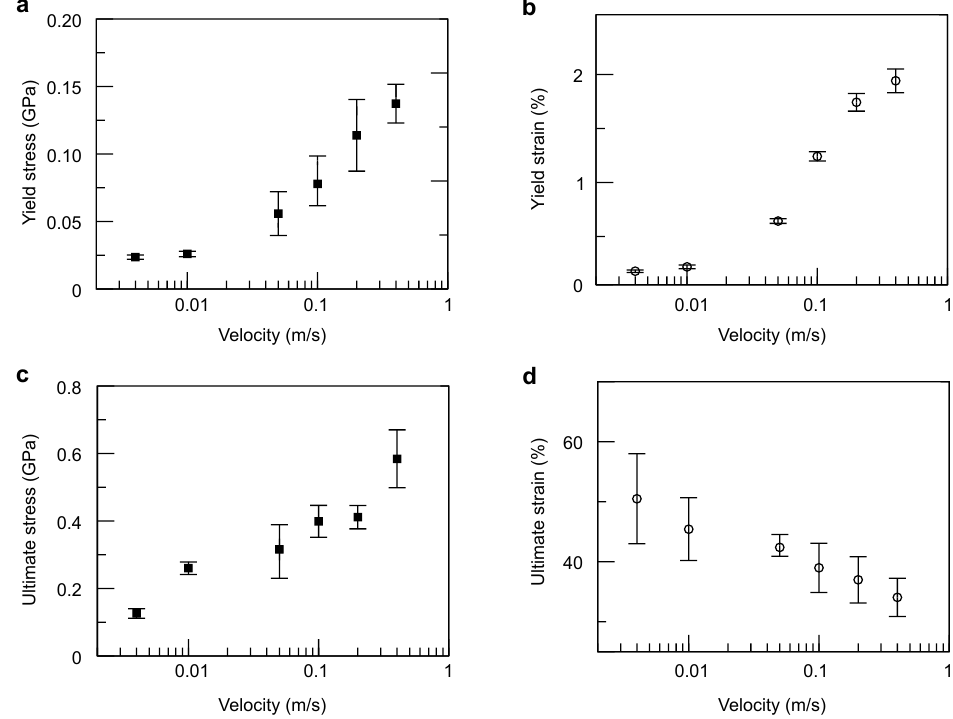
Figure 5. Influences of pulling speed on the mechanical properties of the dragline fiber model. Depicted here are variations in the properties, such as yield stress ( a ), yield strain ( b ), breaking stress ( c ) and breaking strain ( d ) with respect to velocity. Refer to the caption of Figure 3 for the definitions of the parameters mentioned above. Each data point stands for the average with standard errors taken from four different silk fiber random arrangement